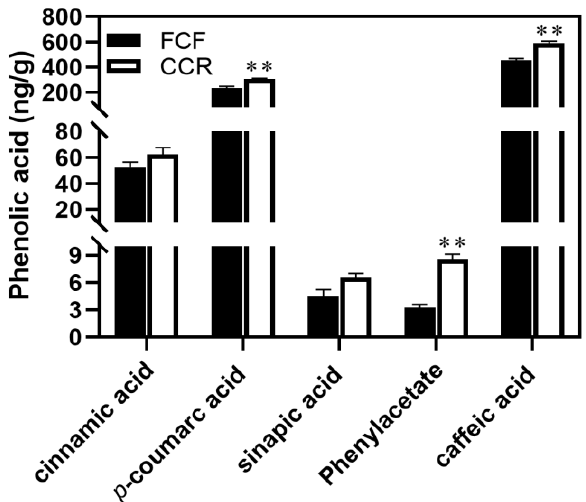
Figure 1. Content of metabolites in phenolic acid biosynthesis pathway in FC and CC rhizosphere soil. ** represent significant at p ≤ 0.01 levels according to Student’s t-test, respectively.